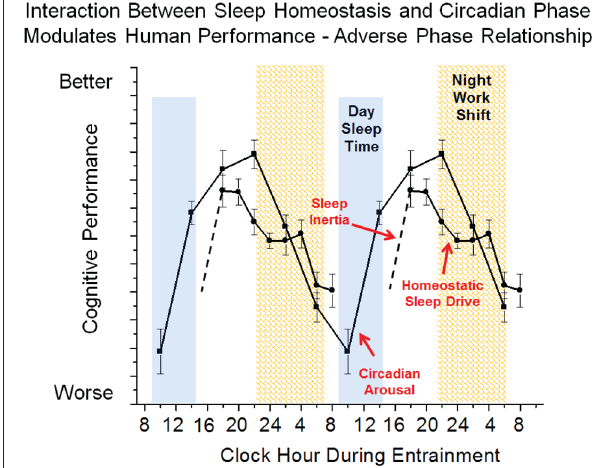
FIGURE 6 | Schematic of the integration of sleep inertia, sleep homeostatic and circadian control systems that modulate cognition, affect, physiology and behavior. Homeostatic sleep drive, circadian rhythms and sleep inertia all interact to influence human cognition, physiology and behavior. Arrows represent direction of influence. Circadian phase and homeostatic sleep drive interact to influence each other and both processes modulate sleep inertia. All three processes independently, and perhaps interactively, influence cognition, affect, physiology, and behavior. Behavior also feeds back to alter sleep homeostasis (e.g., choice to sleep versus engage in other activities) and circadian physiology (e.g., gating of exposure to